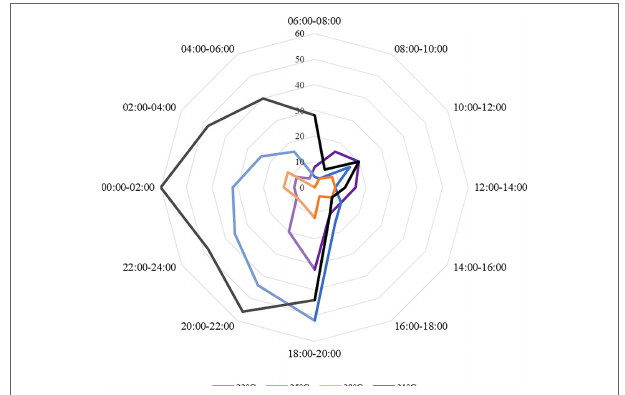
FIGURE 6 | The feeding proportions of S. monotuberculatus changed with time at four temperature conditions.